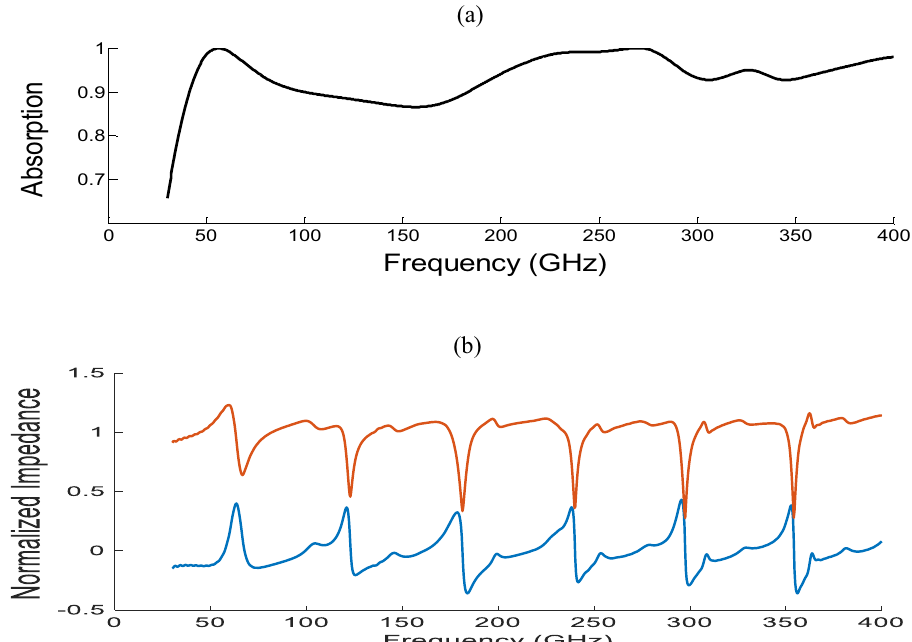
Figure 2. Absorption of the MA with ( a ) the normal incidence and ( b ) normalized impedance of the proposed